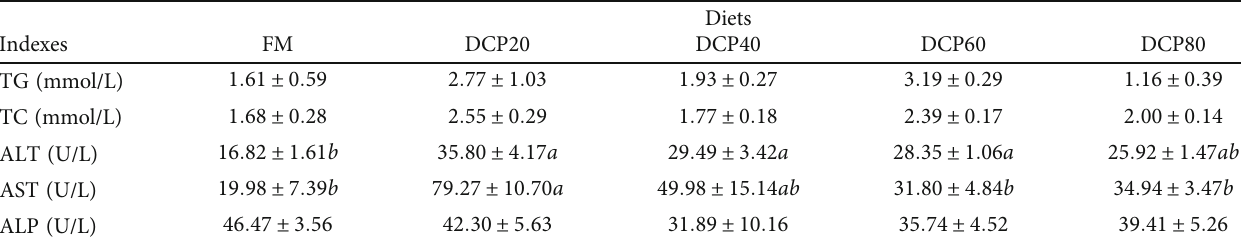
Table 4: E ff ect of degossypolized cottonseed protein on serum biochemical indexes of juvenile fed the trial diets ( means ± SEM, n = 3 ) 1 .